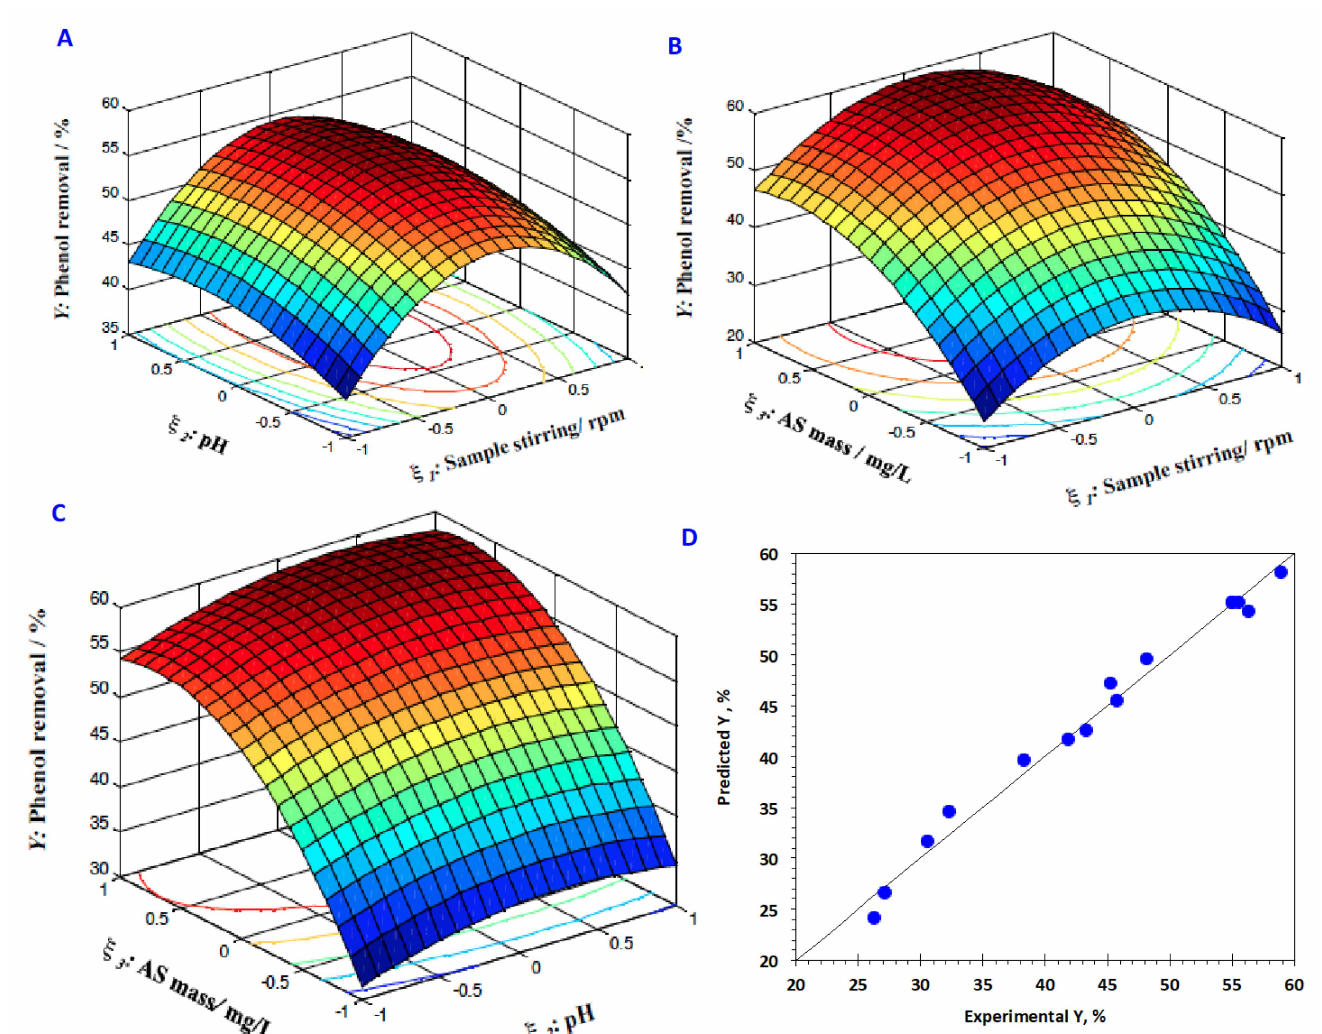
Figure 8. 3D Surface conjugated with 2D contour graphs of the RSM of phenol adsorption, ( A ) sample stirring vs. pH; ( B ) sample dose vs. pH, ( C ) sample stirring vs. sample dose and ( D ) graphical plots of the experimental and predicated